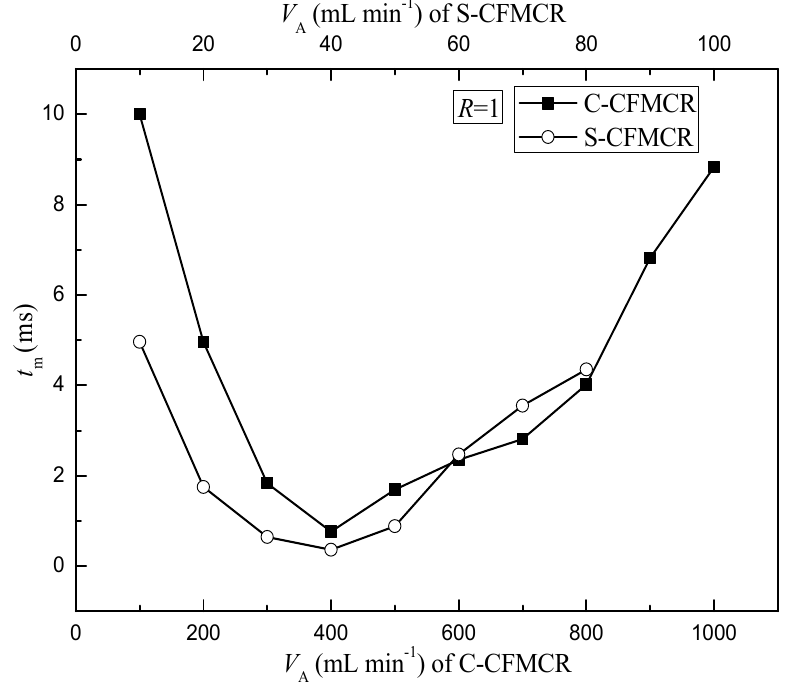
Figure 3. Estimated micromixing time at varying inlet volumetric flow rate.